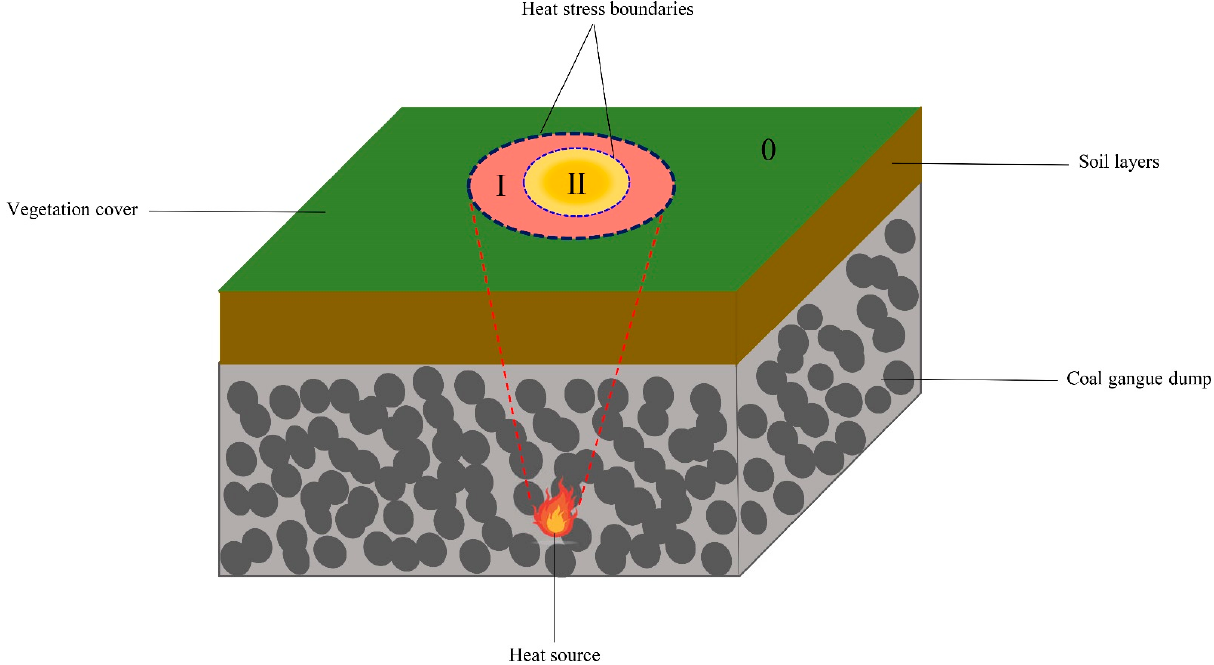
Figure 8. Spontaneous combustion warning levels of the reclaimed coal gangue